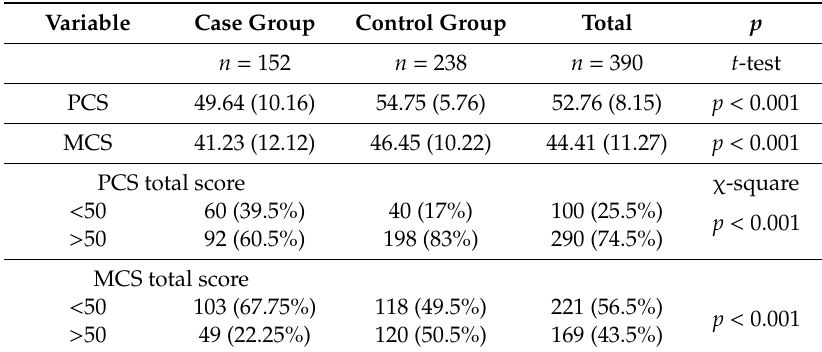
Table 2. HRQOL scores in the case group (women with hypothyroidism) and the control group (women without